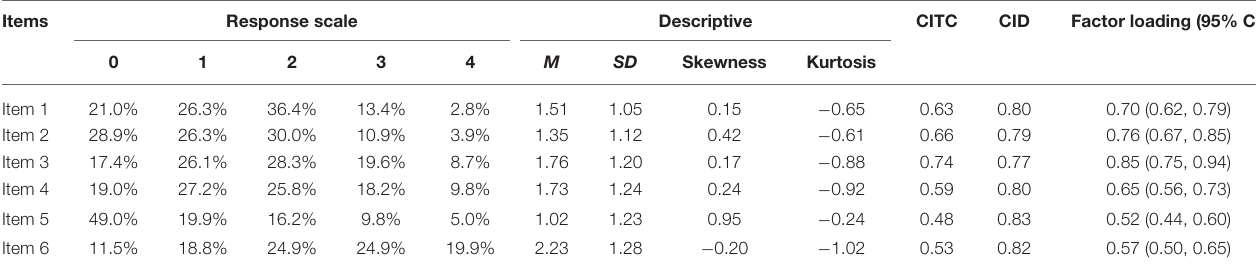
TABLE 2 | Item properties of the Bangla version of the SAVE-6